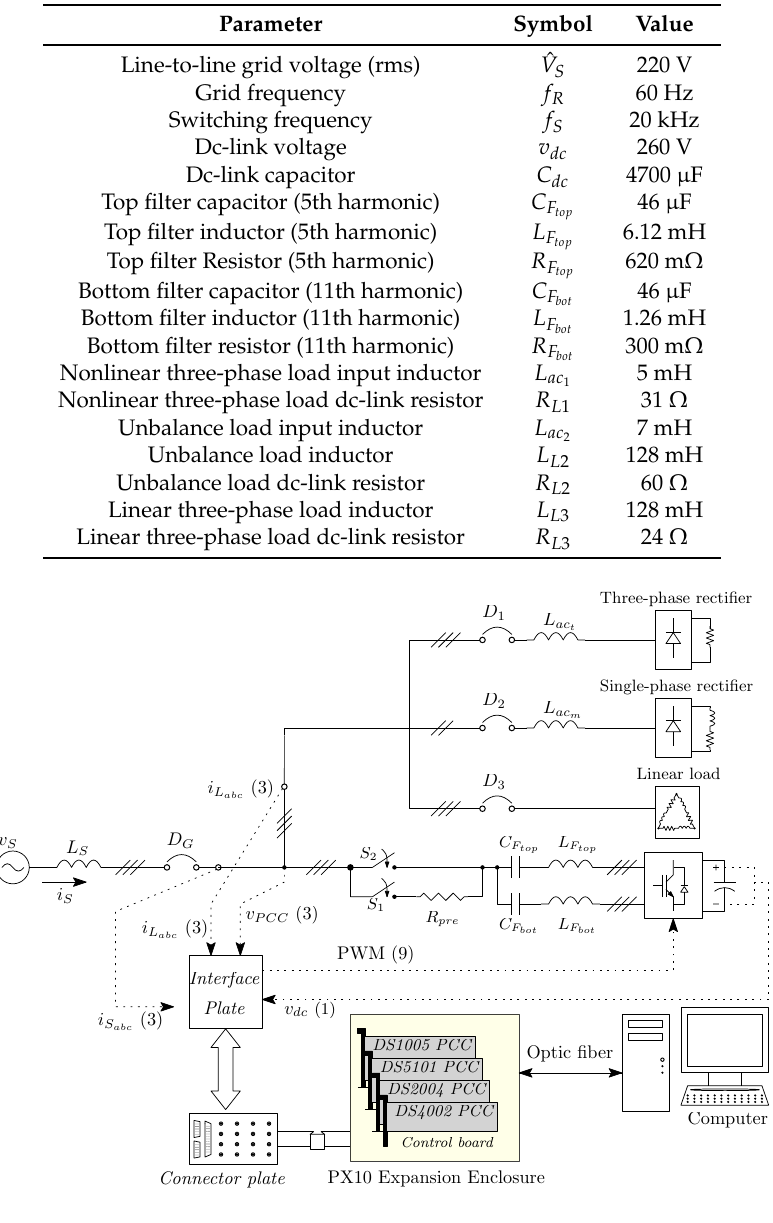
Table 2. Prototype parameters.